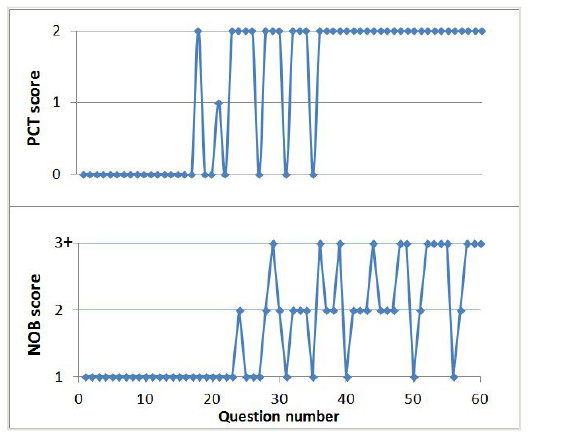
Figure 7. Graphical representation of neurobiological requirements for TONI-4, Form A. The minimal number of objects involved in mental calculations (the NOB score, bottom) and the minimal amount of posterior cortex territory required (the PCT score, top) as a function of question number.